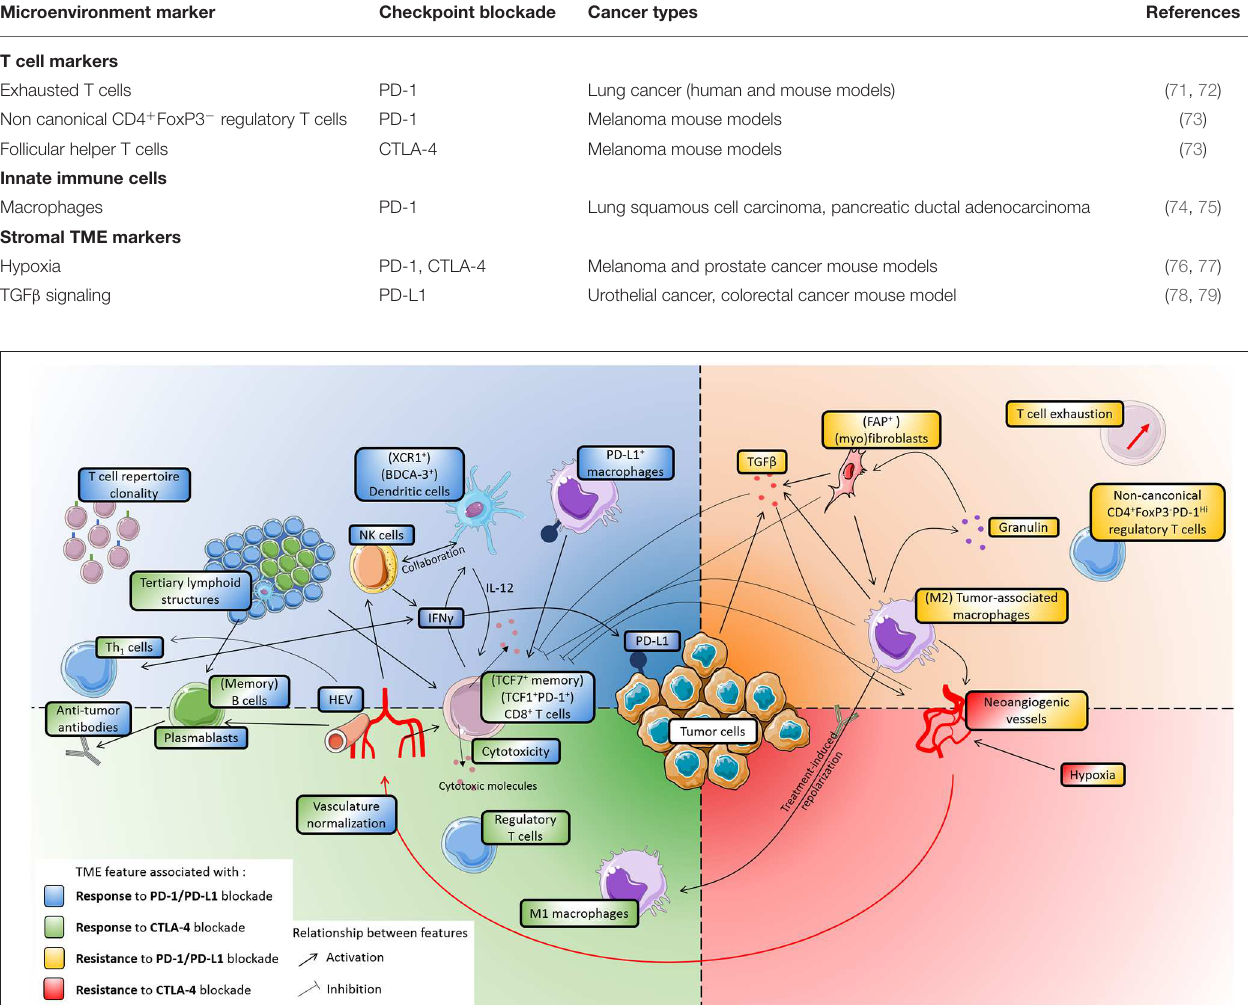
TABLE 2 | Summary of TME components associated with resistance to immune checkpoint blockade.